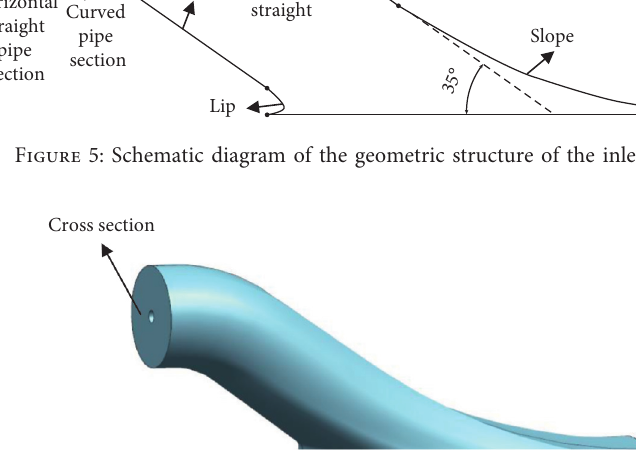
Figure 6: Schematic diagram of cross section.